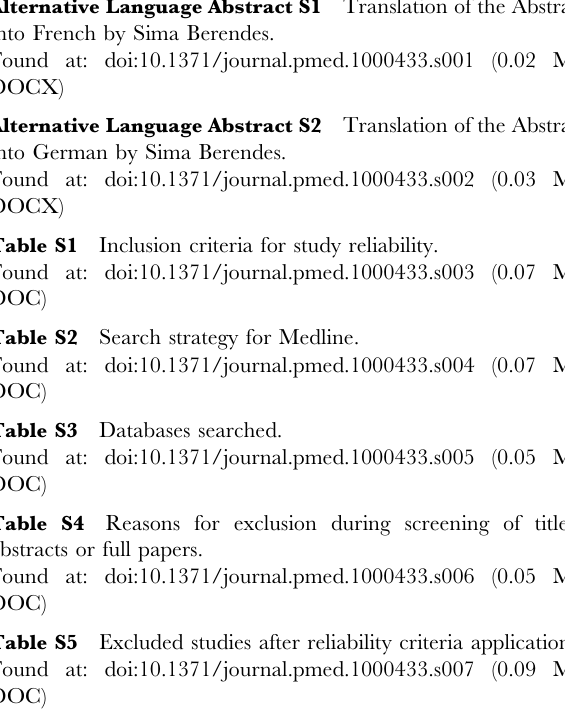
Table S6 Number of studies and comparisons per